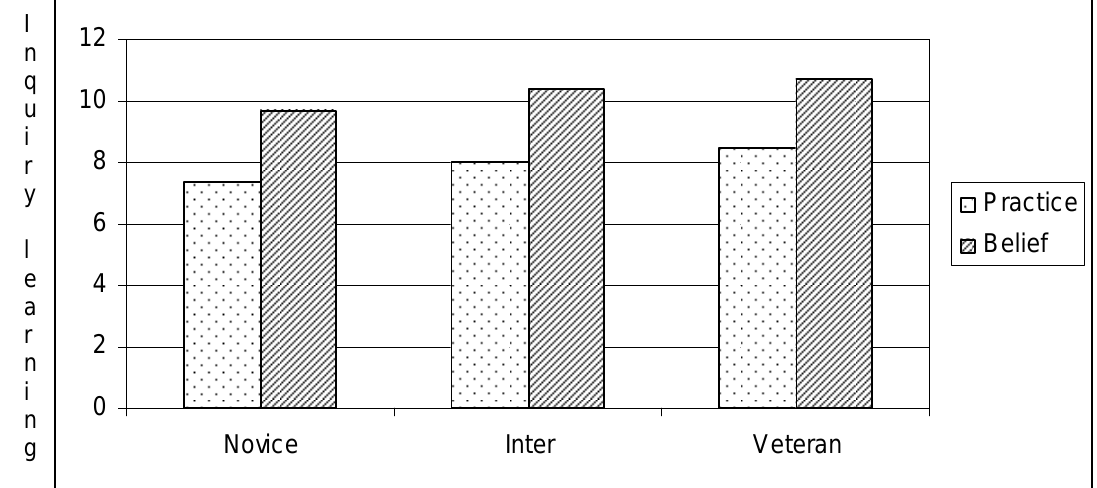
Figure 2. Comparison of participating facilitators’ beliefs and practice in terms of inquiry